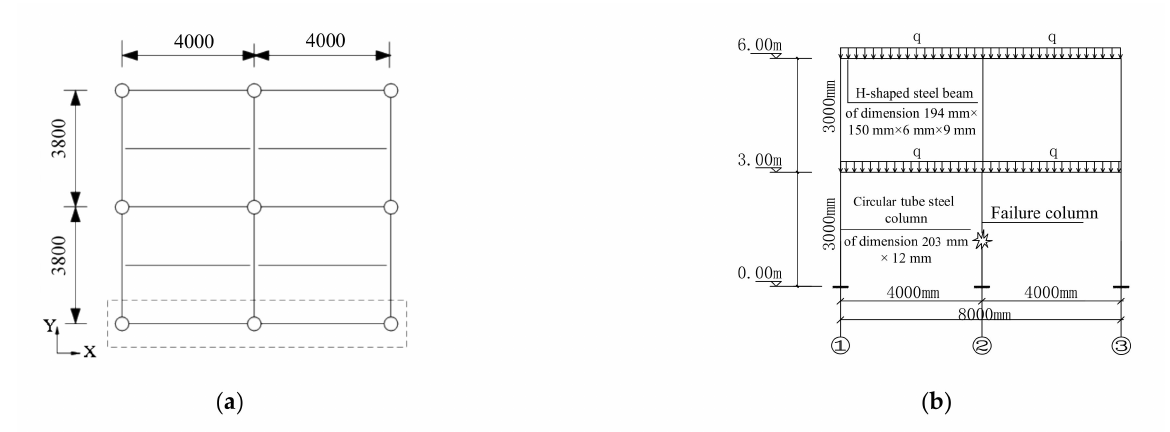
Figure 1. Two-story circular-tube-column frame (unit: mm). ( a ) Plan view; ( b ) Elevation view.